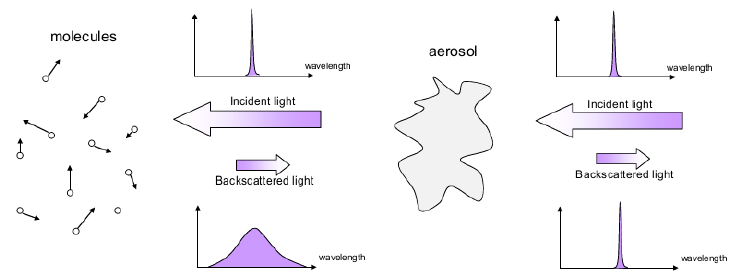
Figure 13. Illustration of the backscattered spectrum.